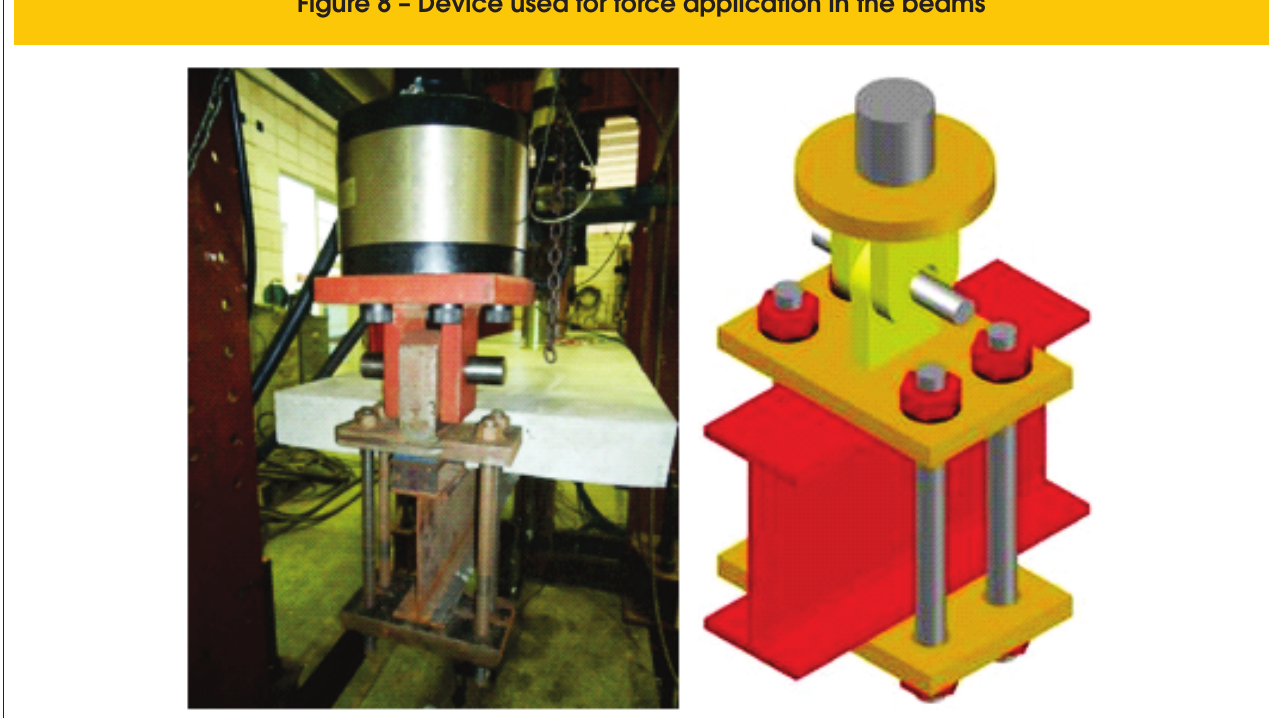
Figure 8 – Device used for force application in the